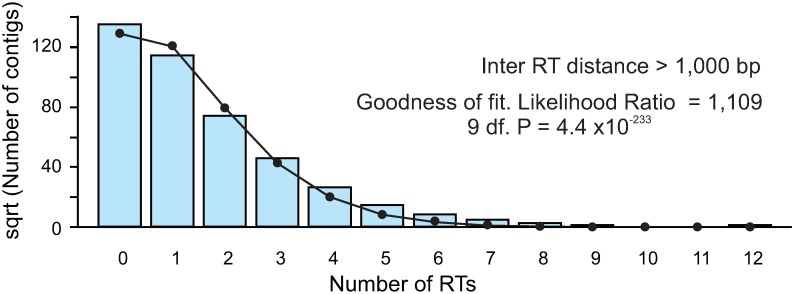
Goodness of fit testing a Poisson distribution of the LTR-RT number according to the square root of the number of contigs.The continuous line indicates the theoretical distribution and bars the real number of contigs within of each class. A between hit distance of > 10,000 bp was considered.